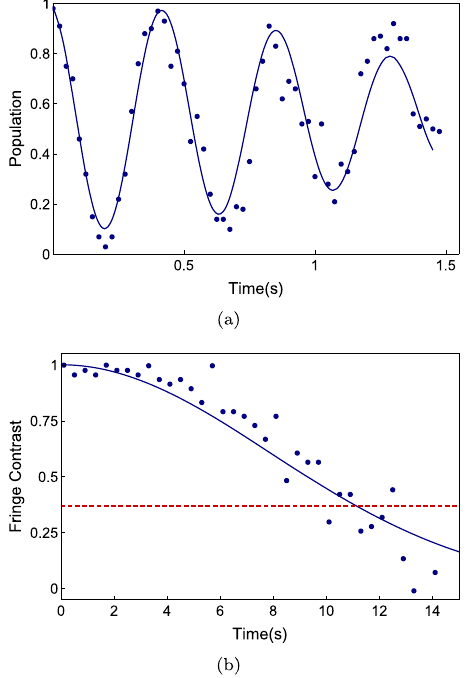
Fig. 9 Coherence time obtained from Ramsey measurements. a without dynamical decoupling pulses and (b) with one spin-echo pulse. Blue points are experimental results and each point repeats 100 times. The solid lines are their fi tting by the Gaussian decay function. (a) A small detuning between microwave frequency and qubit energy splitting is used here to observe the oscillation signal rather than the fringe contrast signal to wipe out the frequency drift effect. The coherence time is 1.6 ± 0.22 s. b The red-dashed line indicates the 1/ e threshold. The coherence time is 11.1 ± shift will be an upper bound of our collision frequency shift because the model does not include the suppression by the sympathetic cooling. We numerically simulate the collision frequency shift with KDD xy sequences. The in fi delity of a superposition state is estimated by around 1.7 × 10 − 9 for each KDD xy unit, which leads the coherence-time limitation to 4 s × 1/(1.7 × 10 − 9 ) ~ 2 × 10 9 s, where we assume the in fi delity increase exponentially with the number of KDD xy gate numbers 59 . (vii) Lifetime of hyper fi ne state: The spontaneous emission rate of magnetic dipole transitions is written as γ ¼ αΔ HF3 j M j 2 , where M is the magnetic dipole matrix 3 m e2 c 4 element that is expected to be of order ℏ , α is the fi ne-structure constant, and Δ HF the energy splitting of hyper fi ne qubit 60 . For the ground hyper fi ne level of 171 Yb + ions, we estimate it as τ HF ¼ 1 γ (cid:5) 5 ´ 10 11 s, where we assume M ~ ℏ . Process matrix evolution . We obtain the T 1 and T 2 in the diagonal elements of χ of Eq. (1) by fi tting χ XY ≡ 0.5( χ 22 + χ 33 ) and χ IZ ≡ 1 − ( χ 11 − χ 44 ) to the functions